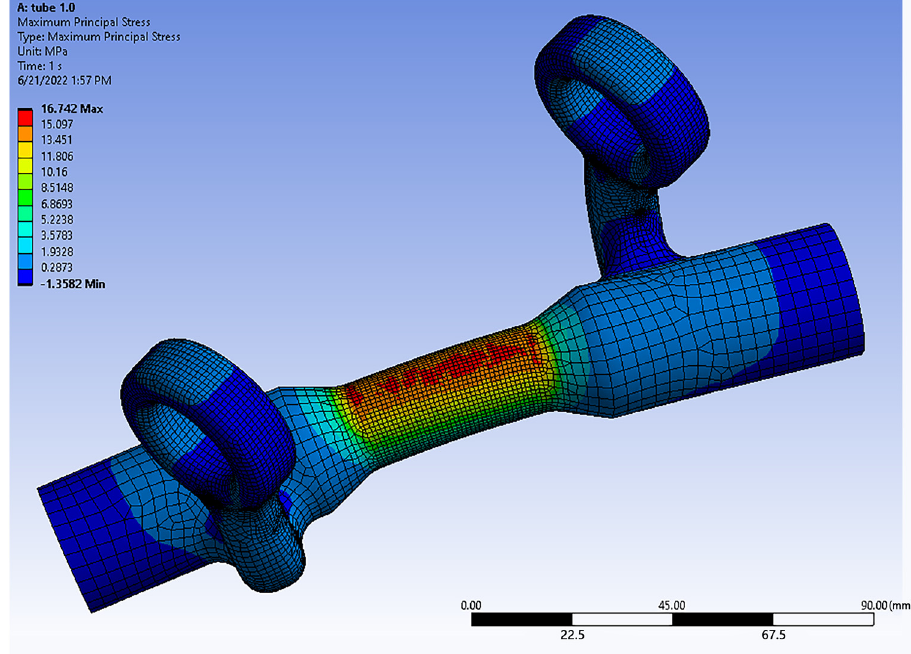
Figure 18. FEA of a combined loading specimen.